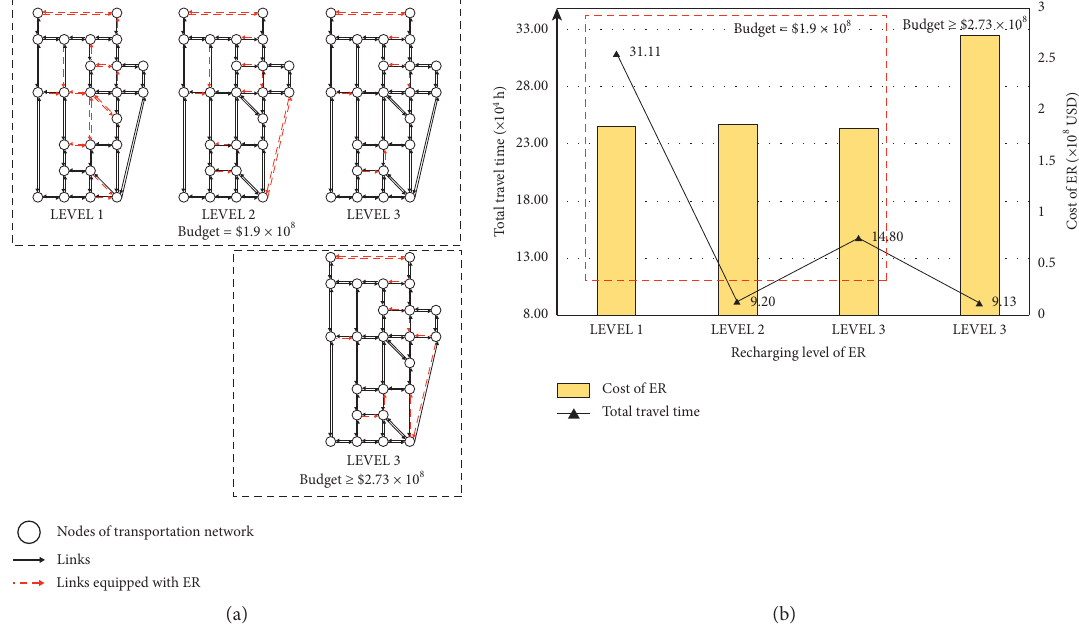
Nodes of transportation network Links Links equipped with Figure 4: Comparison with the ER of different recharging rates. (a) Location designs. (b) Total travel time and cost of the